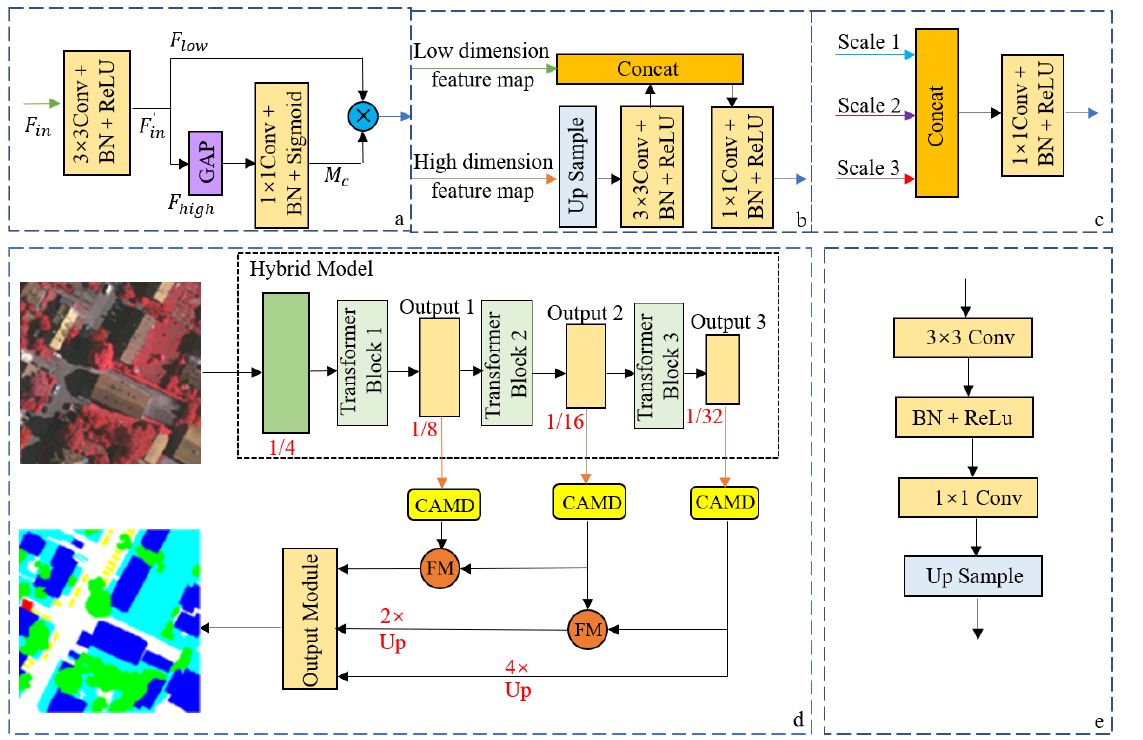
Figure 9. Each module of the network and its overall network structure. ( a ) Channel attention optimization module network structure, ( b ) convergence module network structure, ( c ) infor- mation fusion module network structure, ( d ) overall network structure, and ( e ) output module network